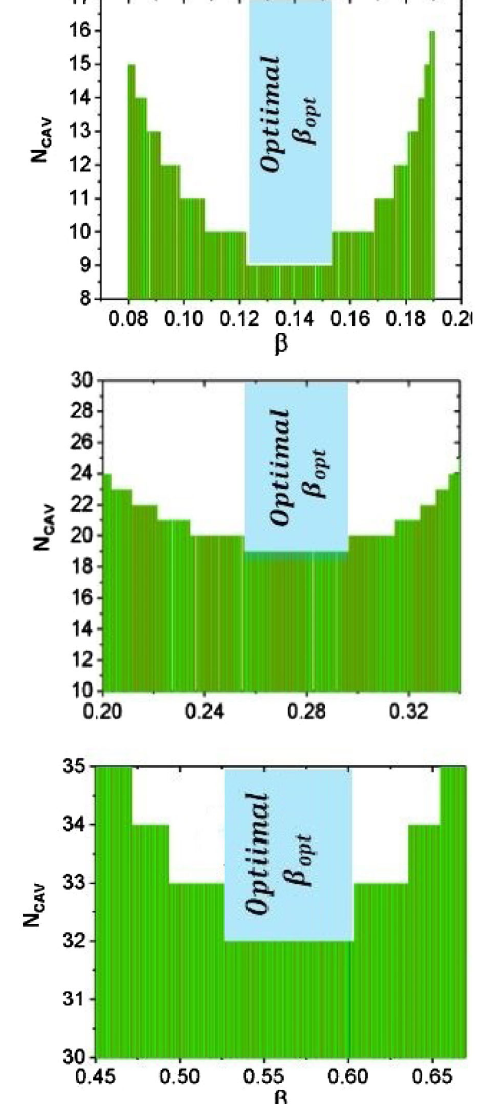
FIG. 15. Number of accelerating cavities and corresponding linac length as a function of β for SSR-A, SSR-B, and opt